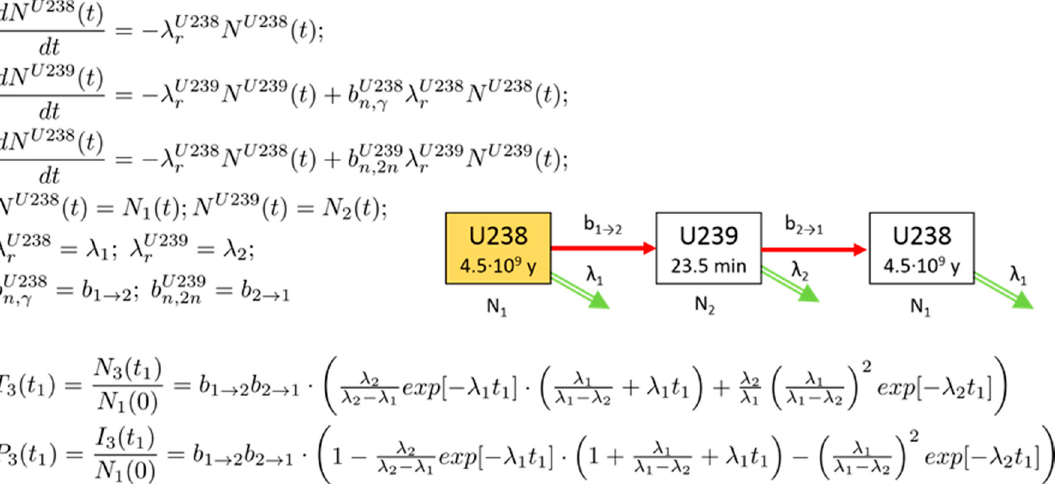
Figure 7. General solution for a cyclic transmutation trajectory in the 238 U chain. Here the density of added nuclide— N 3 will be added to the final destiny of 238 U, as calculated in the first trajectory N 1 , since it also represents 238